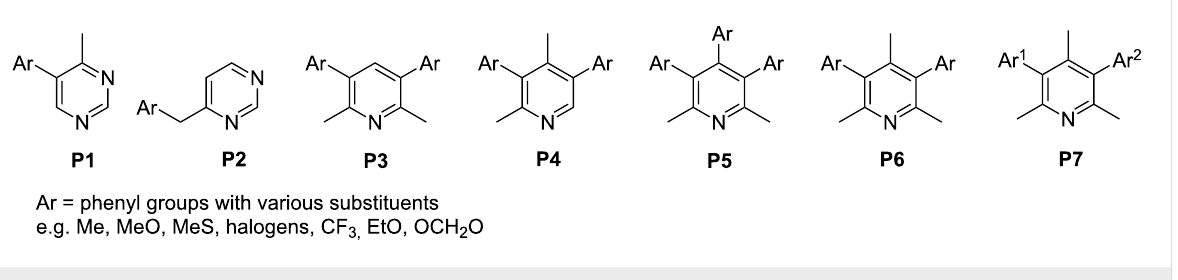
Figure 1: Types of aryl pyridines and pyrimidines already prepared in our group [23-27].